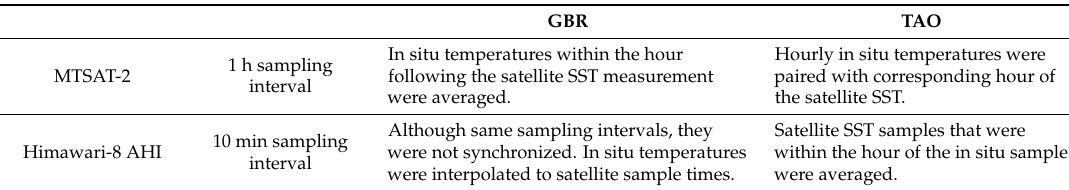
Table 3. Sampling and averaging summary for generating matchups between satellite and in situ measurements.